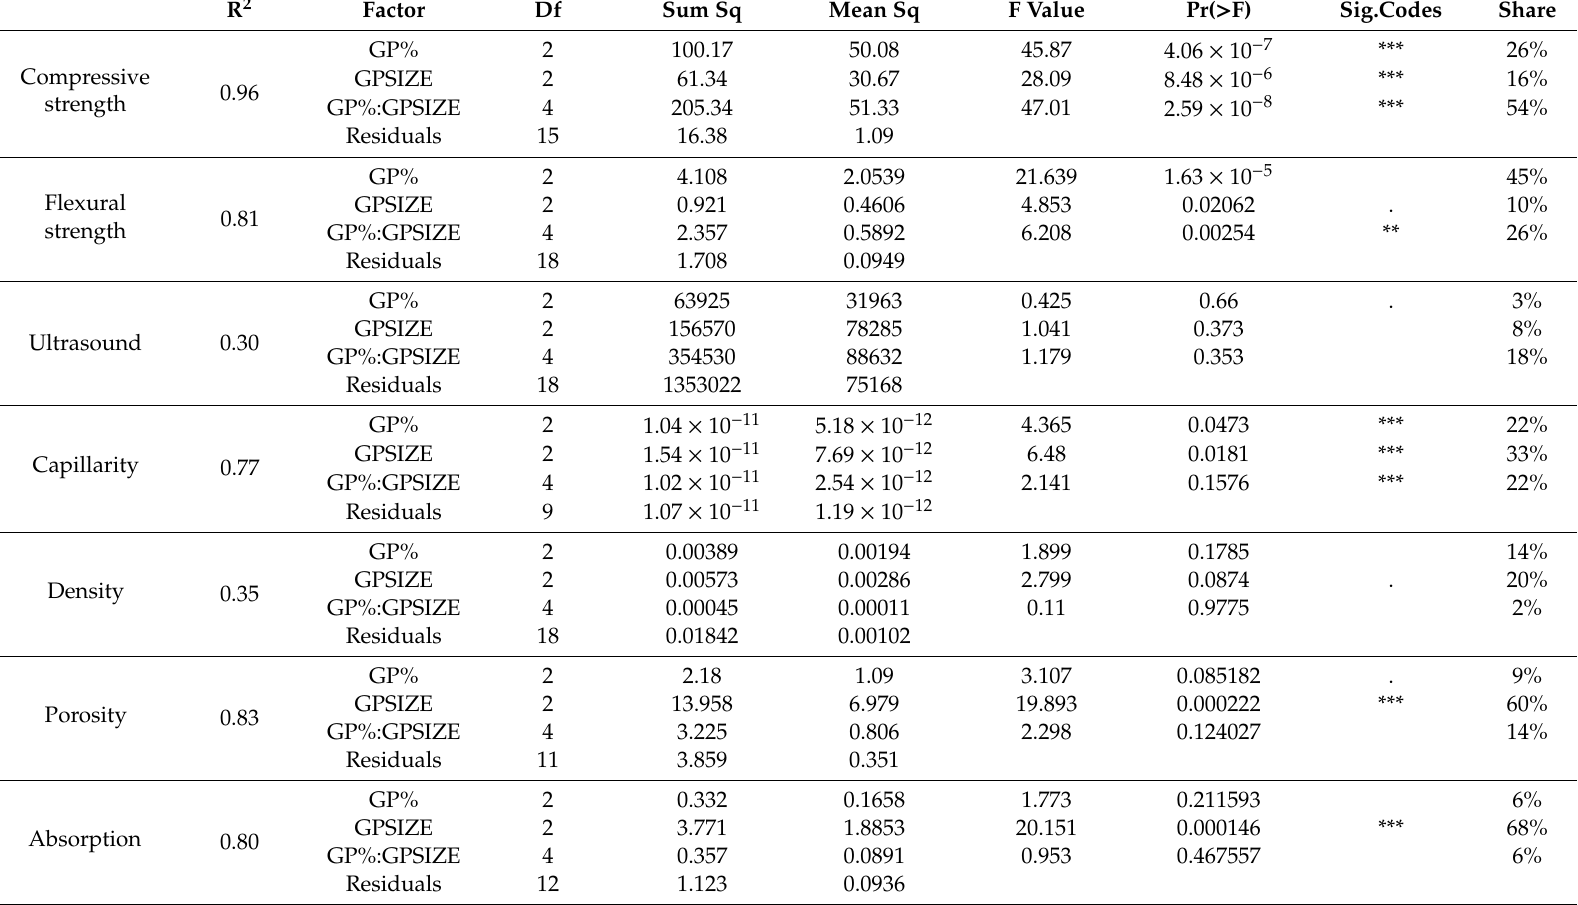
Table 5. Analysis of Variance results for 28 days of